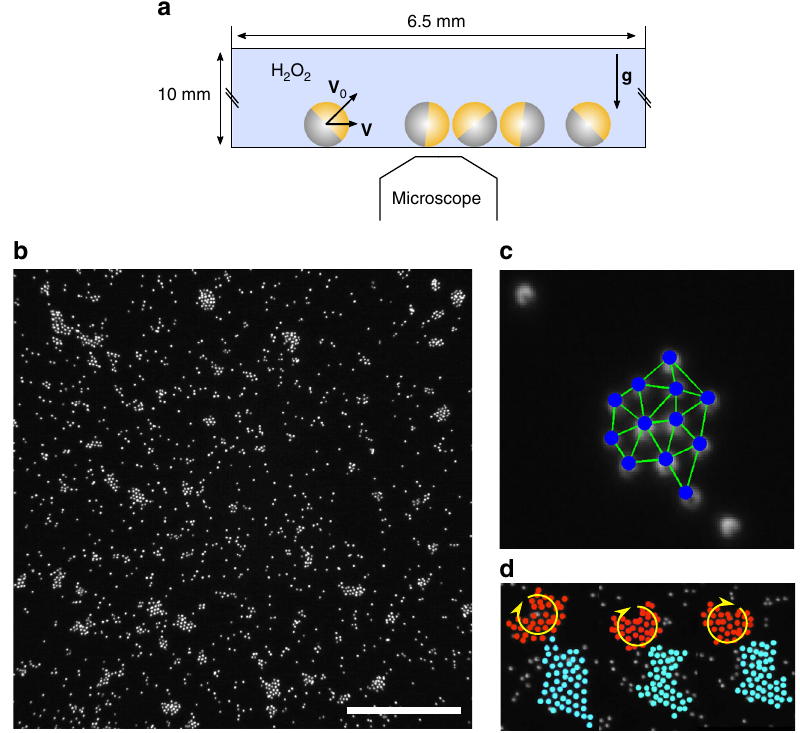
Fig. 1 Experimental observation and de fi nition of active clusters. a Experimental set-up: sedimented Janus microswimmers immersed in a bath of H 2 O 2 fuel. b Snapshot of the cluster phase, scale bar: 40 μ m. c Kinetic de fi nition of clusters based on the detection of time persistent triangles of close-packed particles and on the connected component of adjacent triangles (see text and Methods). d Series of snapshots (for t = 1, 5.4 and 13 s) of cluster-over- cluster rolling motion. A geometric de fi nition of clusters based on a distance-only criterion would identify a single